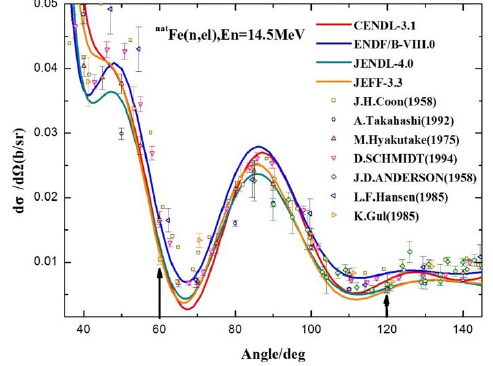
Fig.12 The angular distributions of elastic cross section for iron from different evaluated